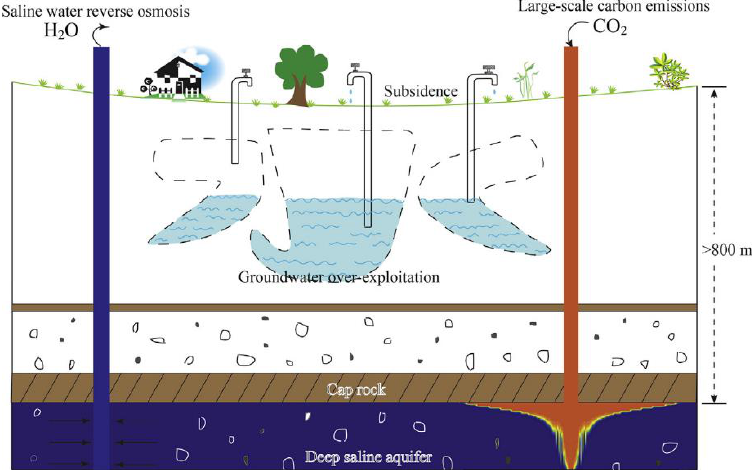
Figure 17. Depiction of the CO 2 -enhanced water recovery (CO 2 -EWR) technology [253].